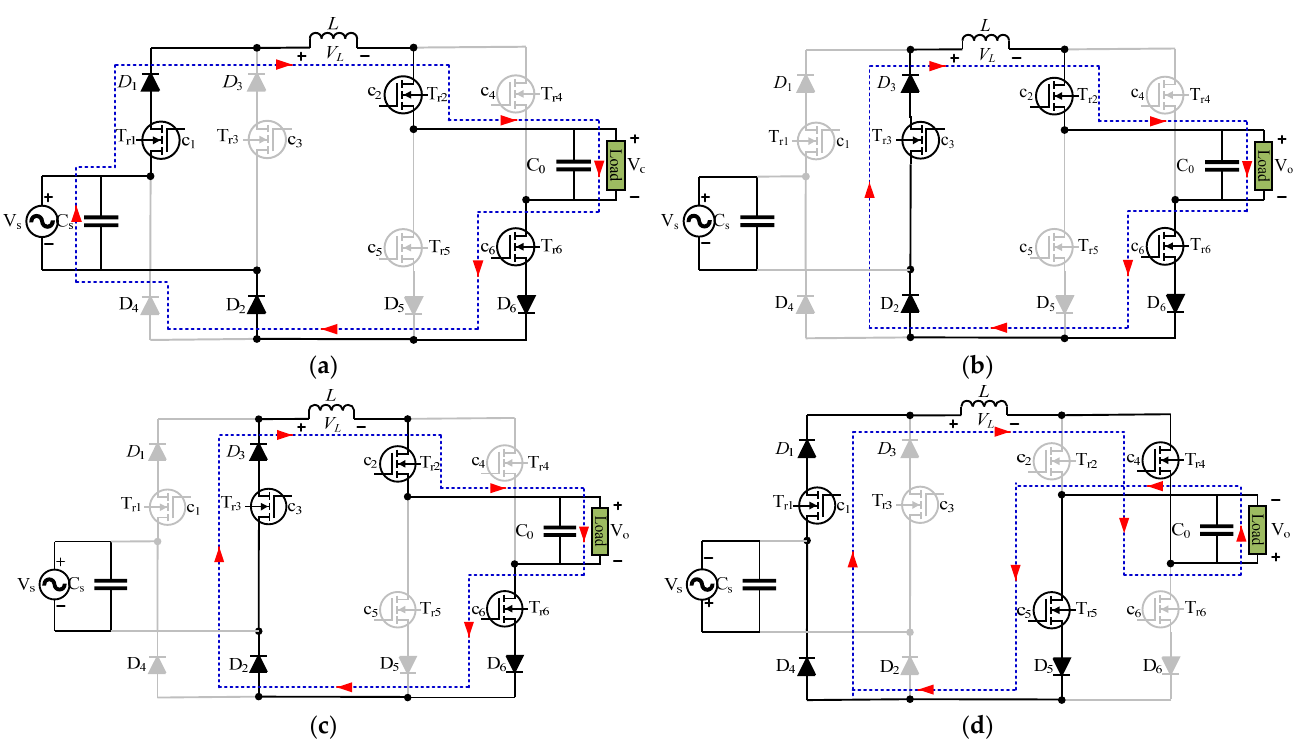
Figure 5. Equivalent power transfer loops formed by PWM control to have non-inverted voltage buck output for half-cycles of ( a ) and ( b ) positive source voltage; ( c ) and ( d ) negative source voltage.